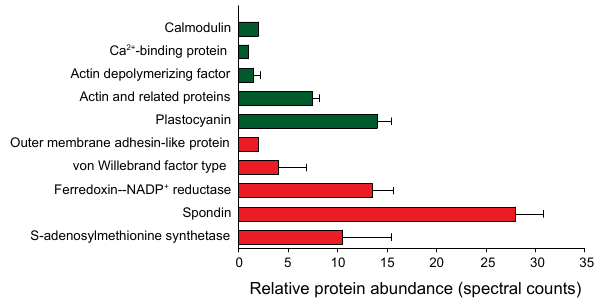
Figure 10. Putative biomarkers identified in the Phaeocystis metaproteome annotated using the field metatranscriptome (error bars represent SD of replicate samples; n = 2; 1-D dataset used). Green bars indicate putative “low iron” biomarkers; red bars indi- cate putative “high iron” biomarkers and correspond to the life cycle stages observed (Fig.